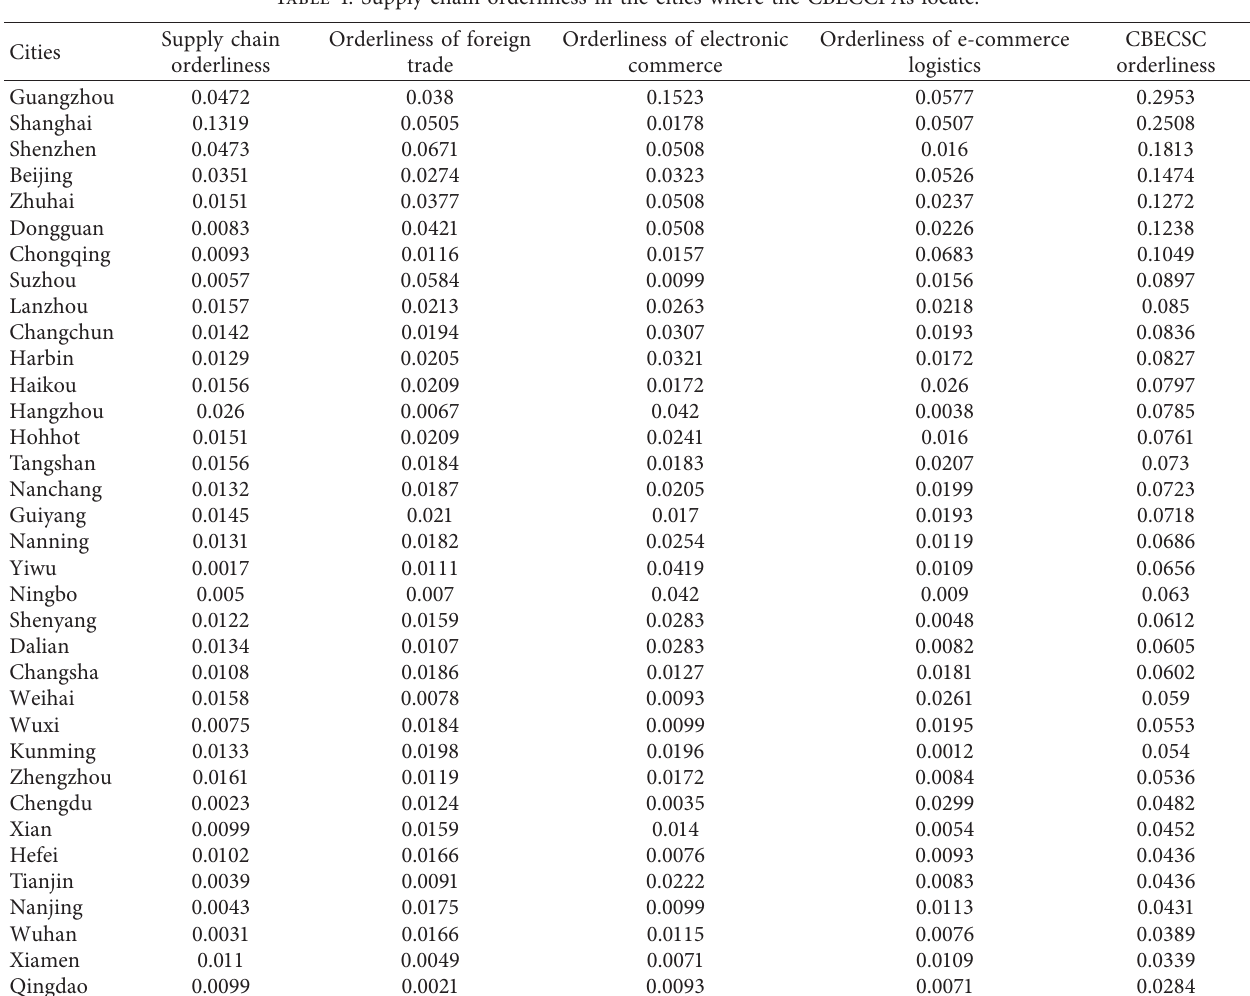
Table 4: Supply chain orderliness in the cities where the CBECCPAs